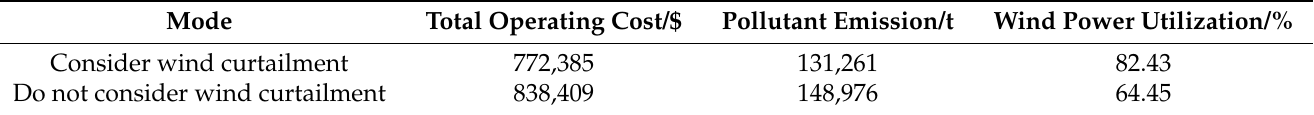
Table 6. System operating cost, pollutant emission, wind power utilization.